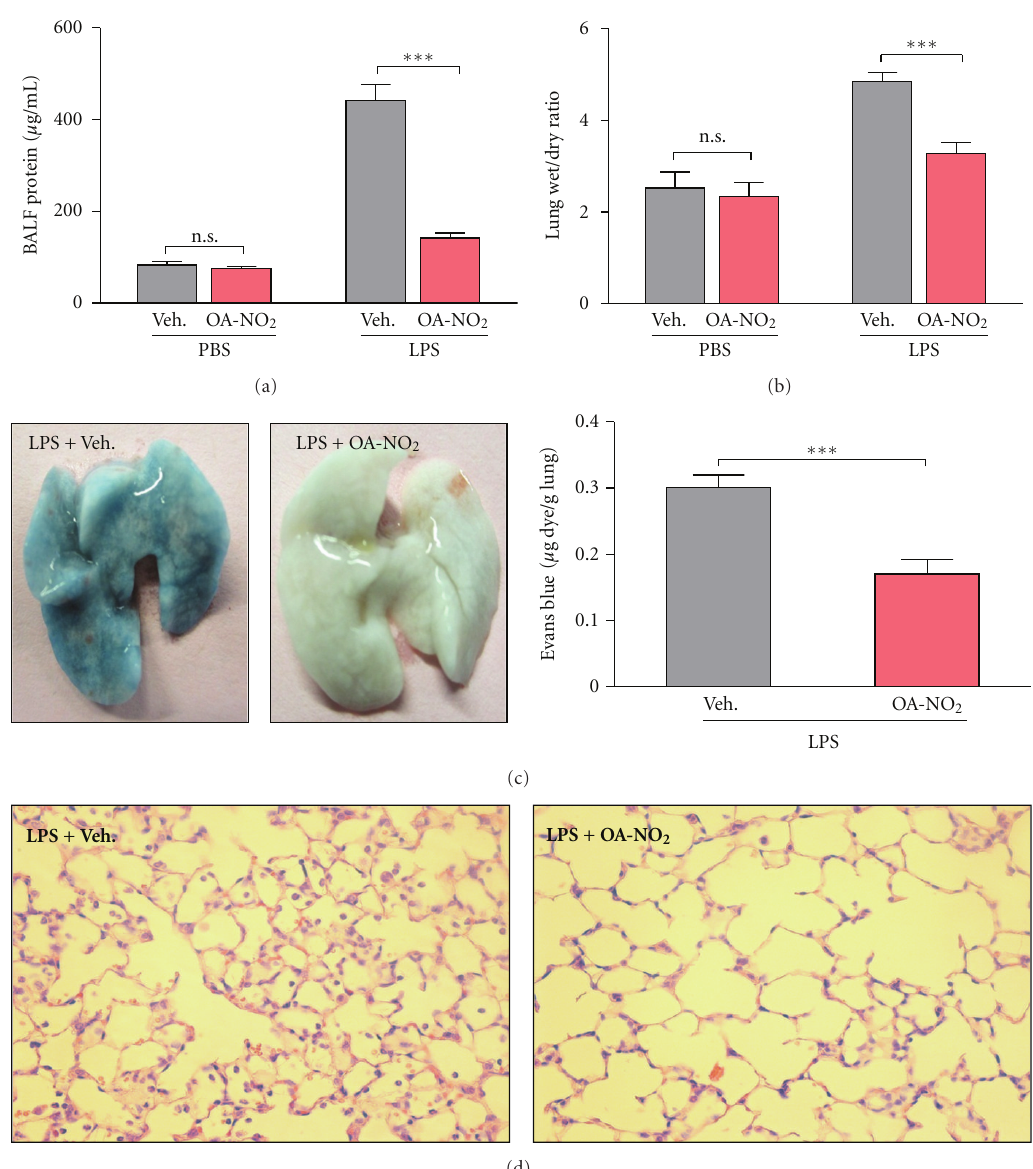
Figure 3: Pulmonary delivery of OA-NO 2 reduces LPS-induced lung injury. Induction of ALI by i.t. injection of LPS (50 μ g) was followed 30min later by i.t. administration (50 μ L) of OA-NO 2 (50 μ g) or vehicle (10% DMSO). After a further 5.5 h, BAL fluid and lung samples were obtained. (a) Protein concentration in BAL fluid. (b) Ratio of lung wet:dry weight. (c) Extravasation of Evans Blue dye into the lung following intravenous injection was photographed and quantitated by spectrophotometry. (d) The lung was examined histologically following H&E staining. Data are representative of one of two independent experiments with n = 6–8 mice per group; ∗∗∗ P <